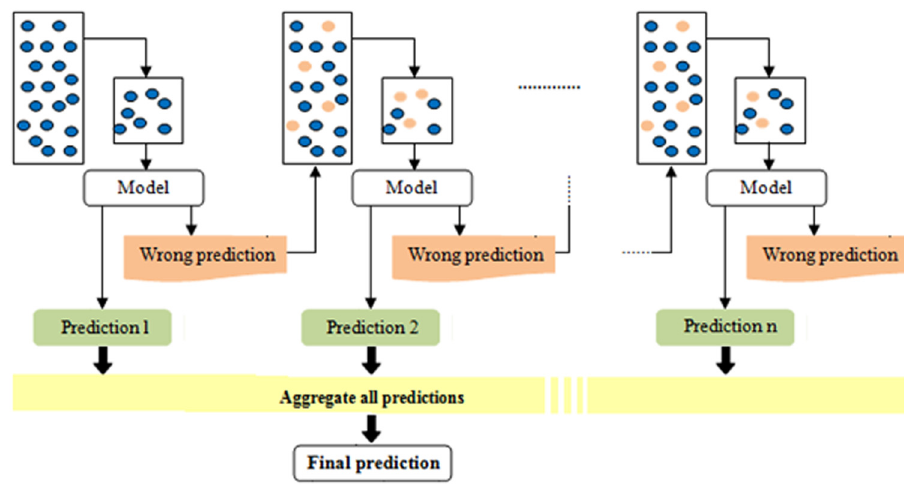
Figure 8: XGBoost - based modeling